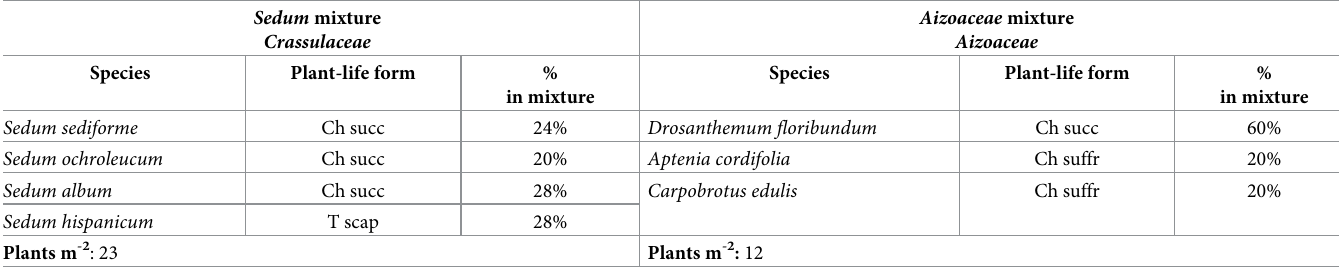
Table 1. Comparison of the plant species used in the two mixtures. Sedum mixture